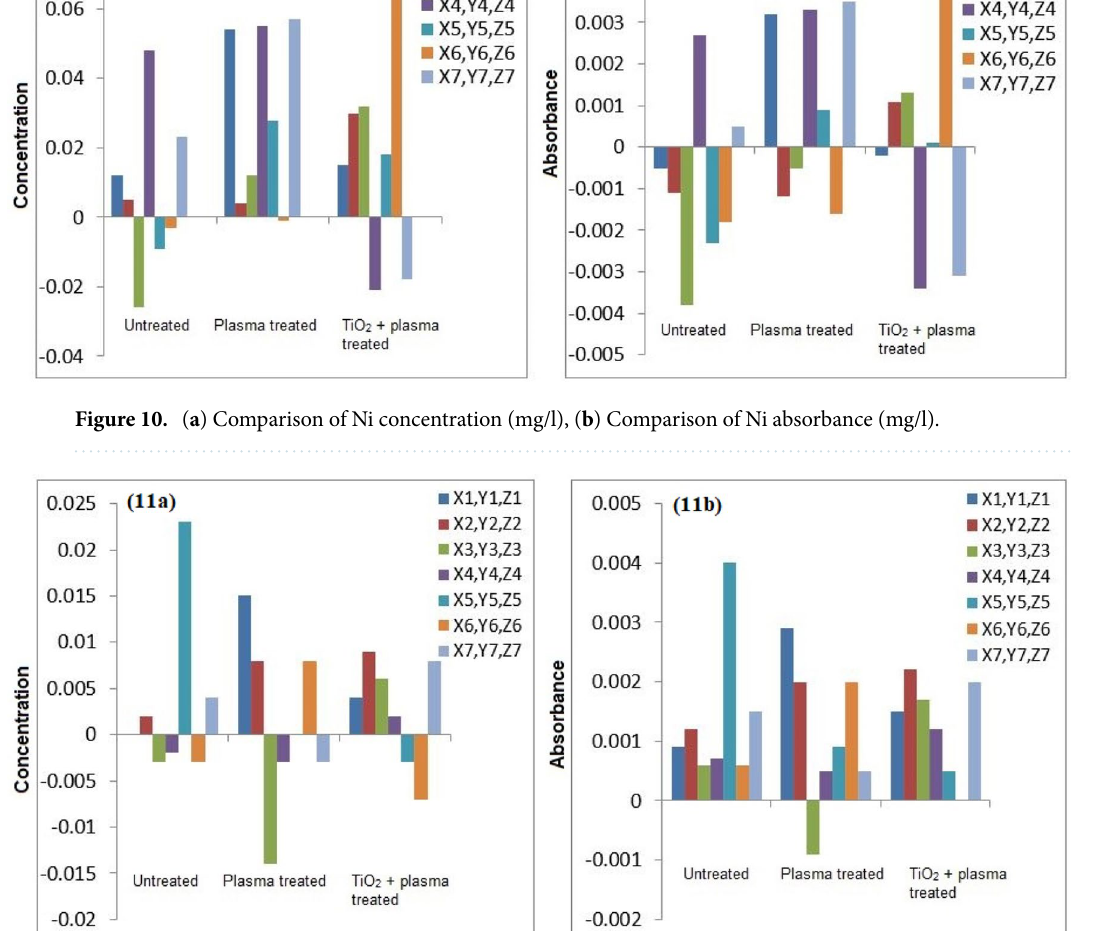
Figure 11. ( a ) Comparison of Cd concentration (mg/l), ( b ) Comparison of Cd absorbance